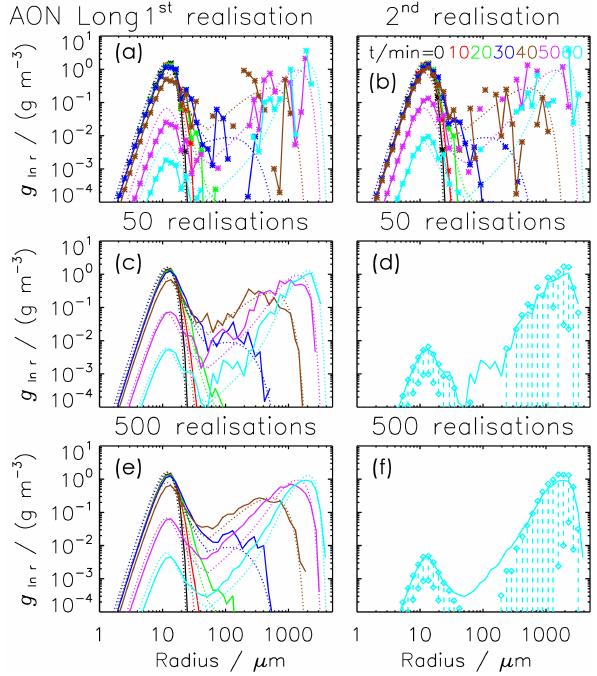
Figure 15. Mass density distributions obtained by AON for the Long kernel from t 0 to 60min every 10min (from black to cyan; = see legend). The dotted curves show the reference solution; the solid curves show the AON simulation results. The top row shows two specific realisations (each symbol depicts a non-zero g value). ∗ Rows 2 and 3 show averages over 50 and 500 realisations: the left column uses the same format as all DSD plots before. The right column depicts the final DSD at t 60min together for each bin; = the interquartile range is determined and depicted by diamonds and a dashed bar. If there is only one (or no) diamond(s) in a bin, the 25th (and the 75th) percentile(s) is (are) too small to be visible. The Figure 14. Moments λ 0 and λ 2 as a function of time obtained by settings are probabilistic singleSIP-init with η 10 − 9 , κ 40 and = = AON for the Golovin kernel. The black diamonds show the refer- (cid:49)t = ence solution. The curves depict the AON results (averages over 50 realisations). The default settings are probabilistic singleSIP- init with weak threshold η 10 − 9 , κ 40 and (cid:49)t 1s. Left col- = = = umn: default simulation (red), larger time step ( (cid:49)t 20s, blue) and = fewer SIPs ( κ 10, brown). Right column: ν const -init (brown) and = ν draw -init (blue).